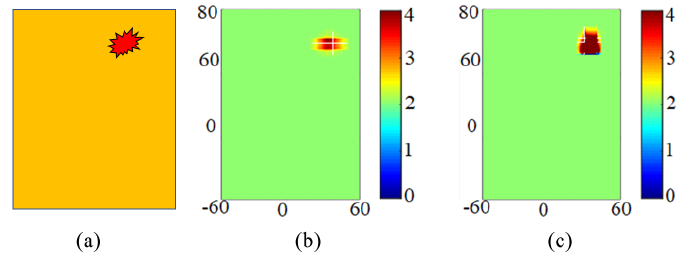
Figure 8. Image of tumor detection by selecting and placing irregular miniaturized tumor; ( a ) Irregularly shaped tumor; ( b ) Reference wide-band antenna; ( c ) Switchable filter wide-band antenna.